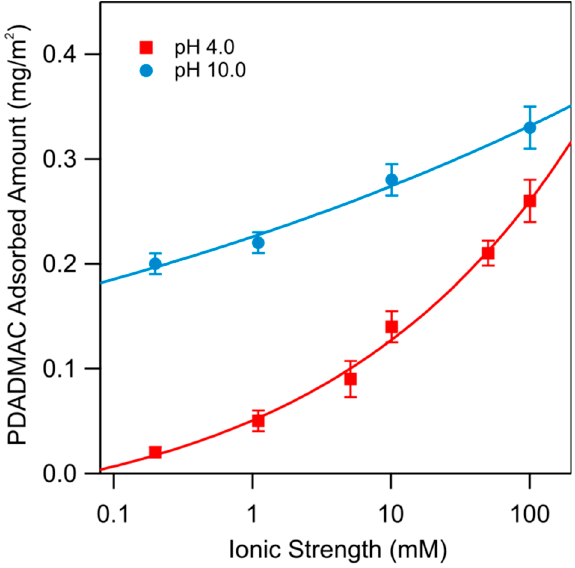
Figure 3. Adsorbed mass of the saturated PDADMAC adsorbed layer on silica as a Figure 1a,b. For both cases, a root mean square (RMS) roughness of 0.19 ± 0.02 nm was found. This similarity can be understood since the polyelectrolyte adsorbs in a flat conformation, and explores the existing corrugations of the original substrate.